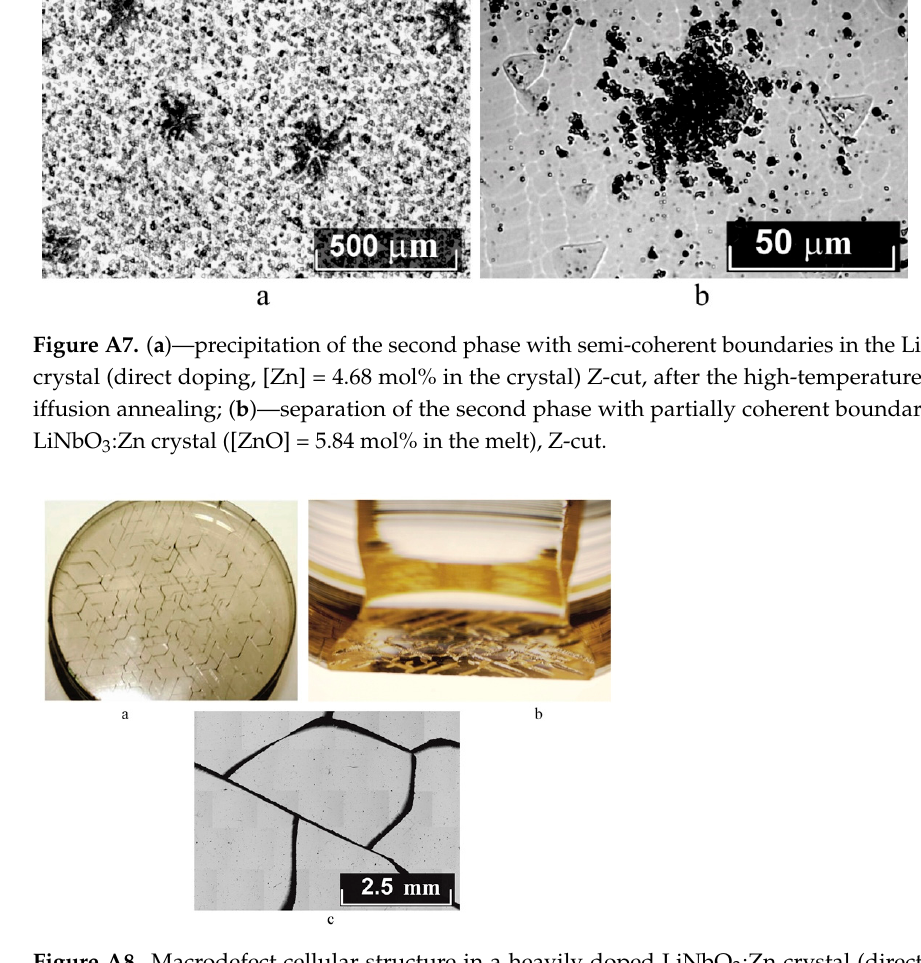
Figure A8. Macrodefect cellular structure in a heavily doped LiNbO 3 :Zn crystal (direct doping): ( a )–At the bottom of a large boule, observation in a bright field; ( b )–On the Z surface through the X surface, observation in a bright field; ( c )–observation in the DIC mode.